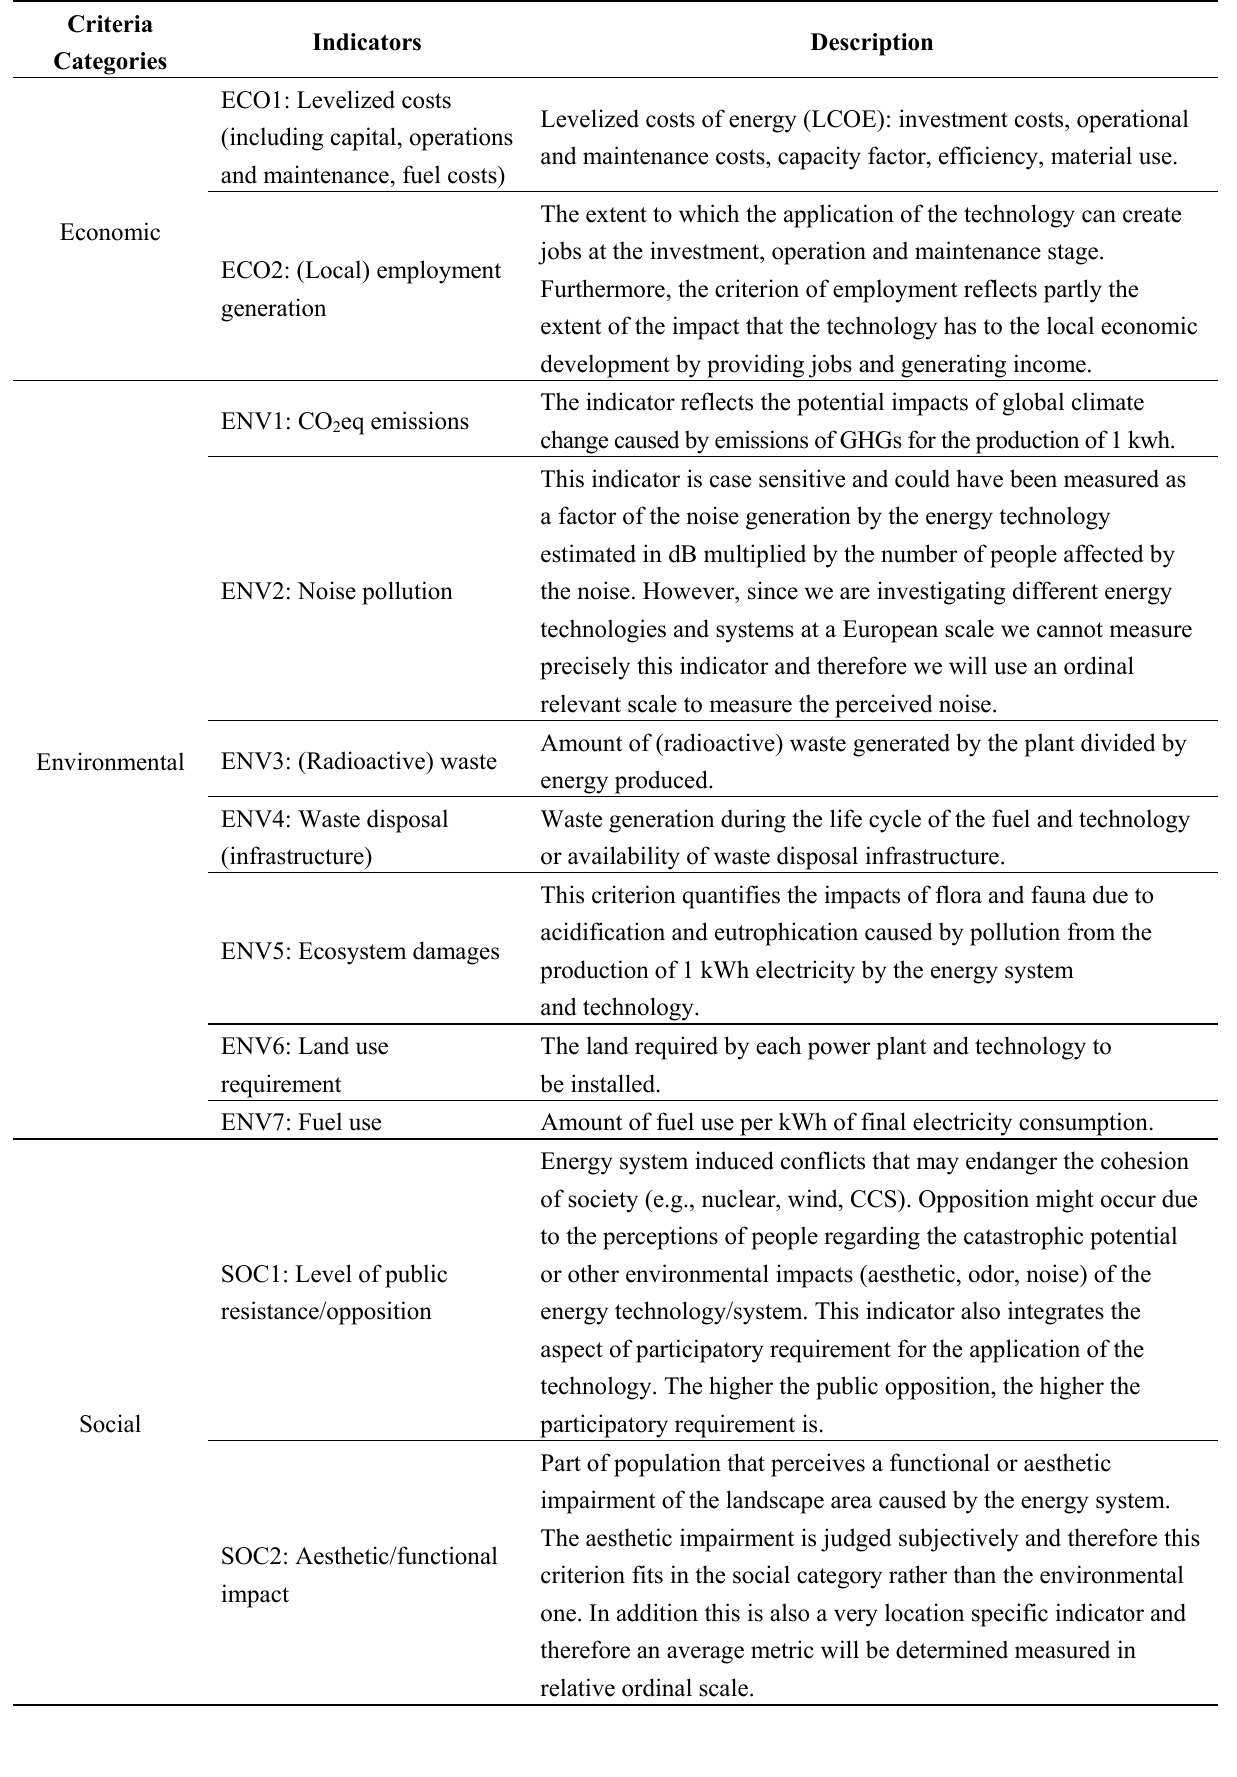
Table 1. Final set of selected and validated evaluation criteria and